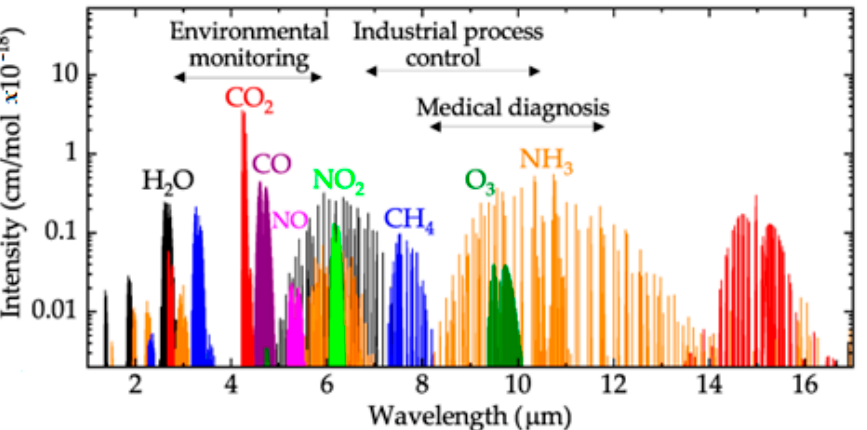
Figure 2. Midinfrared absorption spectra of selected molecules with their relative intensities. H 2